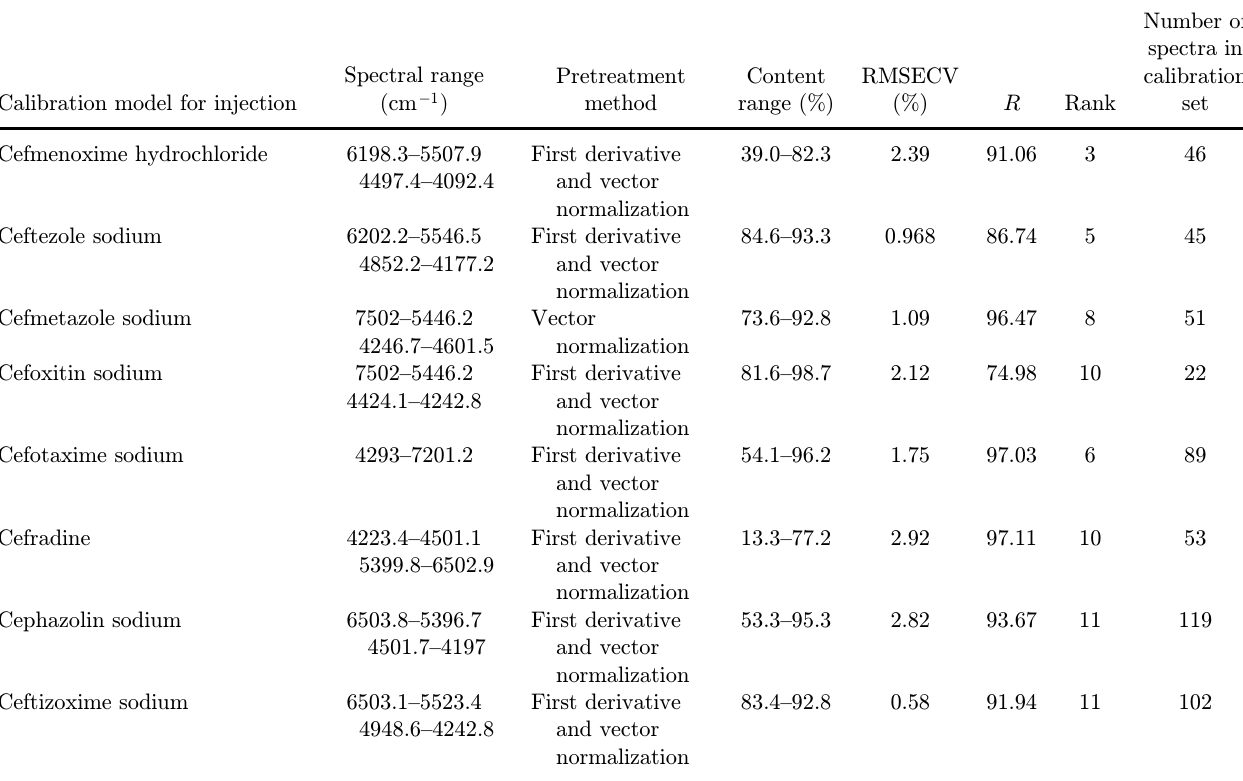
Table 5. Model characteristics of other cephalosporins using Ranges I and III.